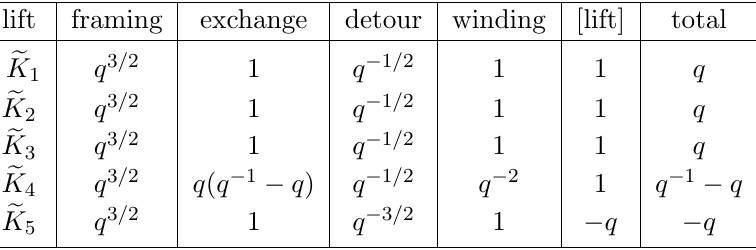
Figure 27 . A lift e K 5 of K . Left: the standard projection. Right: a link obtained from e K 5 by applying gl (1) skein relations.